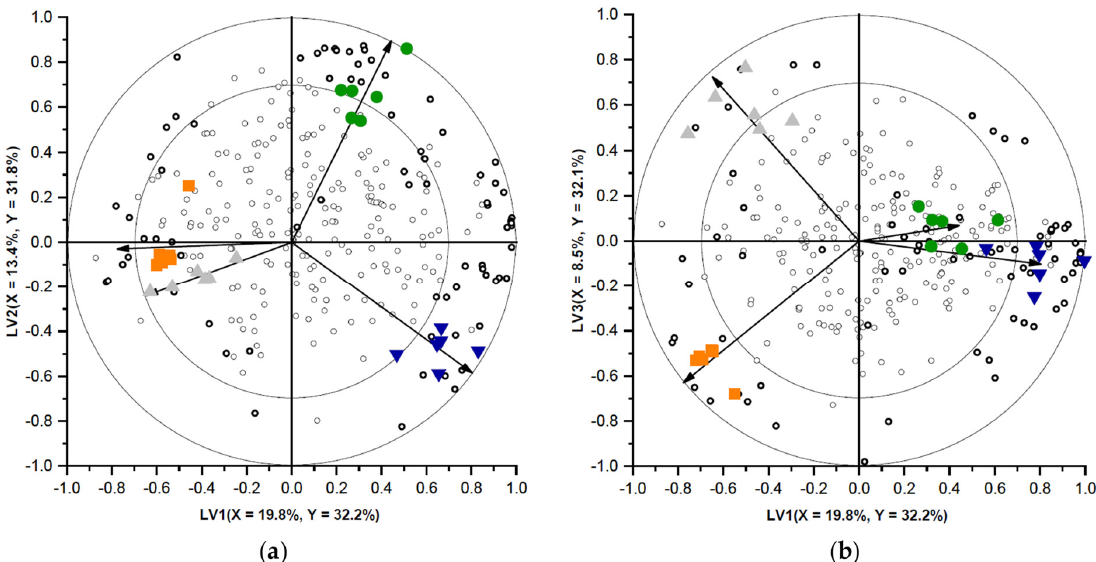
Figure 7. Biplot of LV1 versus LV2 ( a ) and LV1 versus LV3 ( b ) of a PLS-DA-model representing the volatile headspace components of the reference soup ( ● ) and soups containing non gelatinised open cell chickpea flour (NG-O) ( ▼ ), pre-gelatinised open cell chickpea flour (PG-O) ( ▲ ), and pre-gelatinised commercially available chickpea flour (INS) ( ◼ ). The percentage of X - and Y -variance explained per LV is shown on the axes. Soup samples are represented as coloured symbols and volatile components are represented as open circles. Markers with |VID| > 0.7 are represented as bold circles. The vectors represent the correlation loadings for the Y -variables (classes). The outer and inner circles on the biplot represent the correlation coefficient of 1.0 and 0.7 respectively, indicating the area where the most important discriminating volatiles are presented.